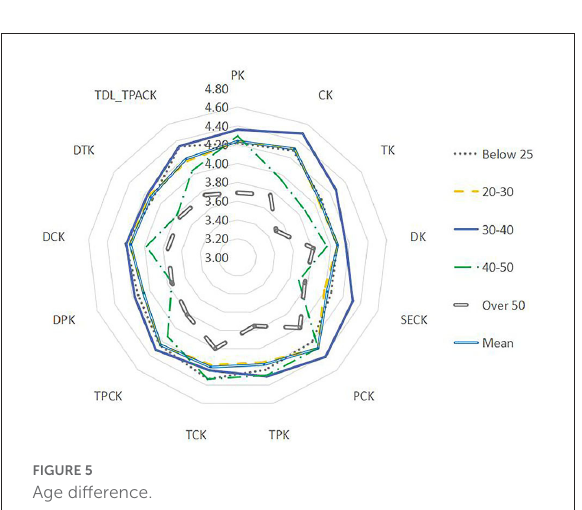
FIGURE5 Age difference.